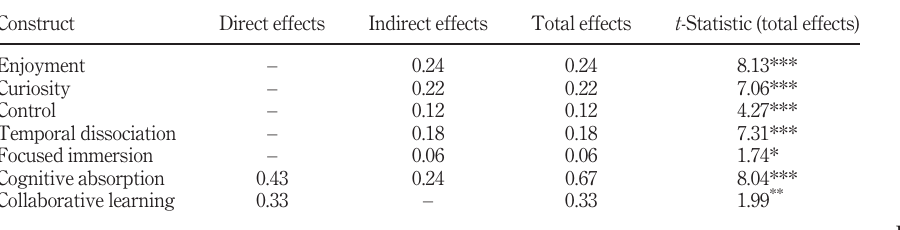
Table IV. Direct, indirect